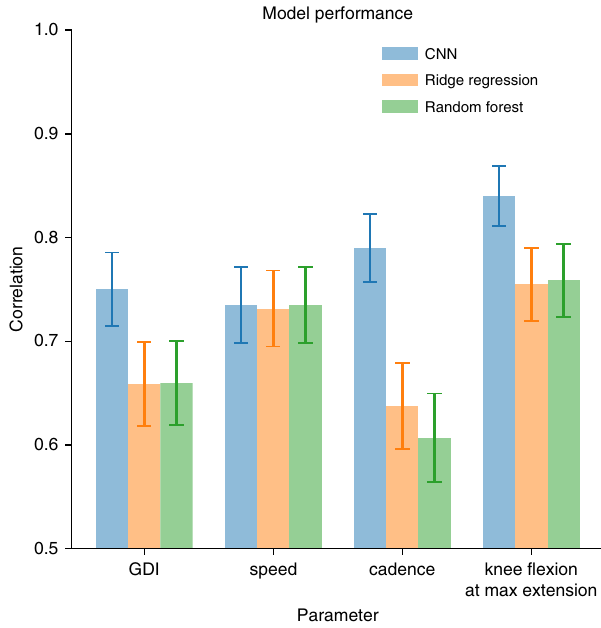
Fig. 2 Comparison of prediction accuracy for models using video signals.